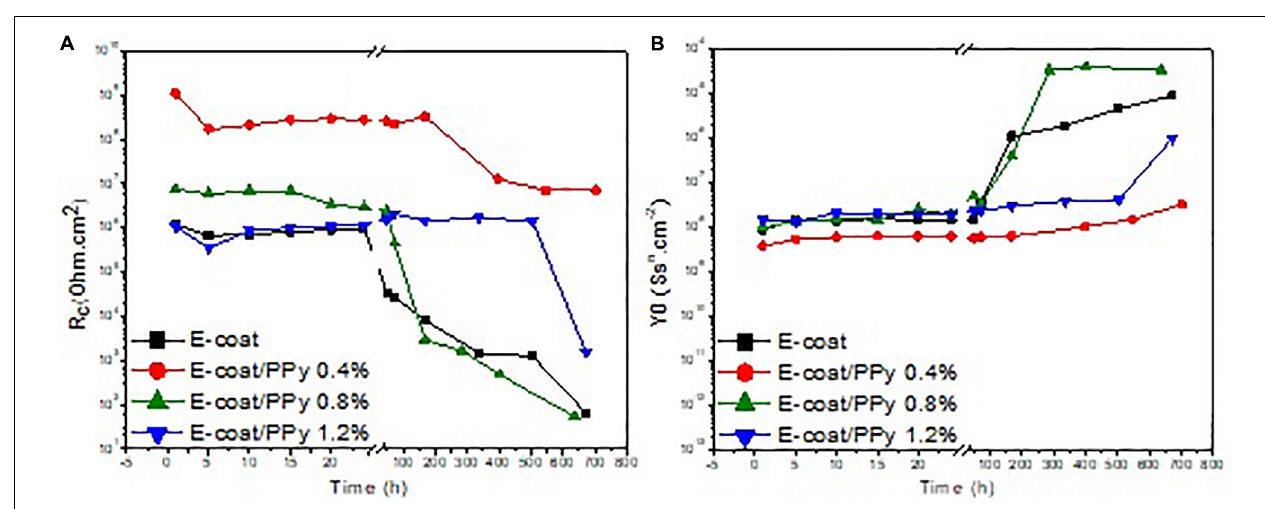
FIGURE 8 | Electrical parameters evolution (A) R c and (B) Q c over time for the AA1200 coated with neat e-coat and e-coat/PPy 0.4%, 0.8%, and 1.2% by weight.